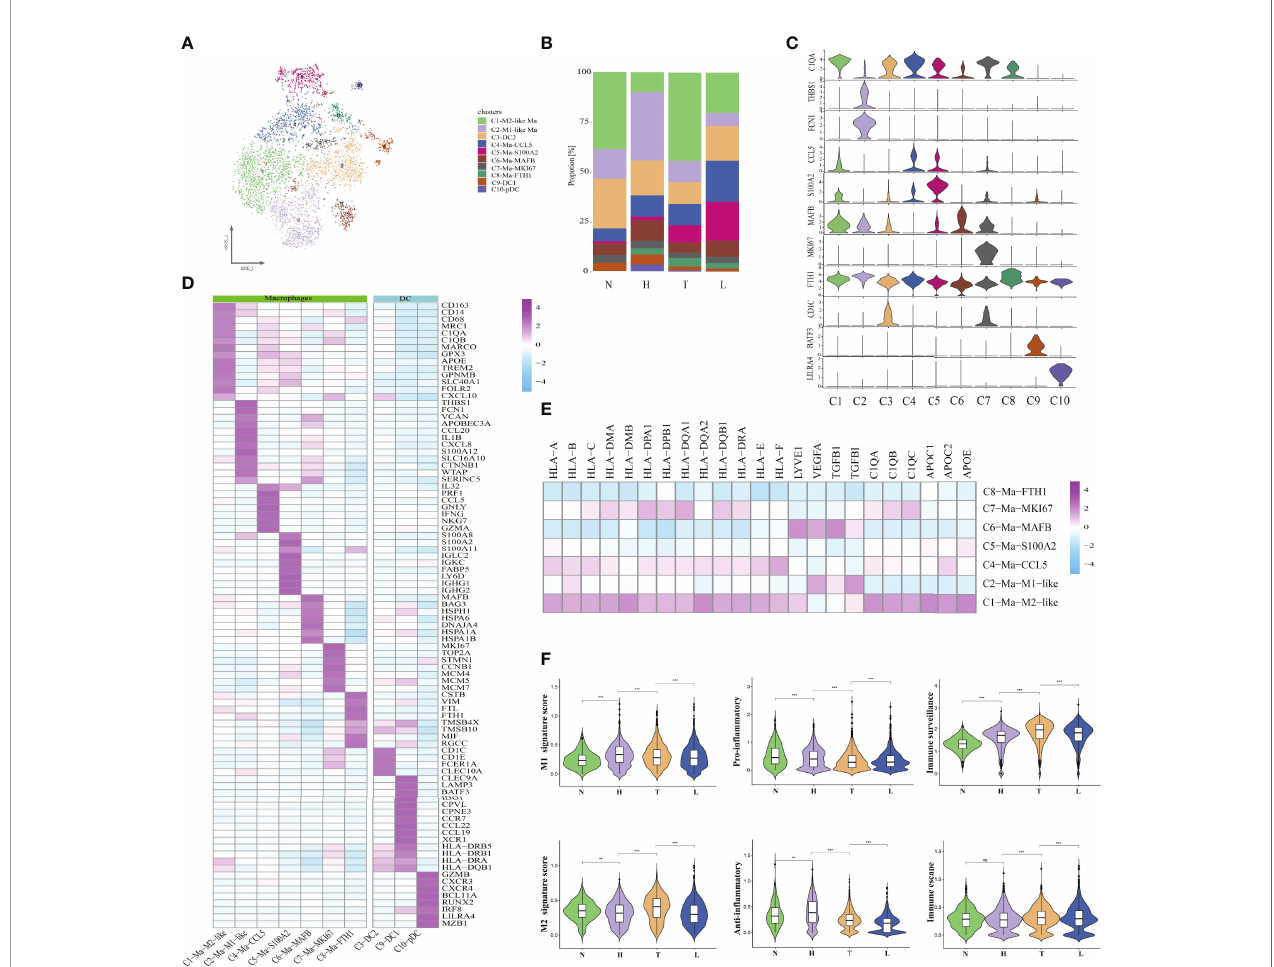
FIGURE 4 | Identifying distinct myeloid cell clusters in all samples. t-SNE projection of 10 subsets of myeloid cells (each dot corresponds to one single cell) shown in different colors (A) . Proportions of all cell types clusters among four groups (B) . Violin plots representing the distribution module score for selected genes for each cluster. Error bars indicated the means ± SD (C) . Heatmap indicating the expression of selected gene sets in myeloid cell subtypes (D) . Heatmap indicating the differentially expressed genes in seven macrophages subtypes (E) . Violin plots showing the scores of functional modules for each macrophages cluster, using the AddModuleScore function. (**P < 0.01; ***P < 0.001) (F) . NS, no signi fi